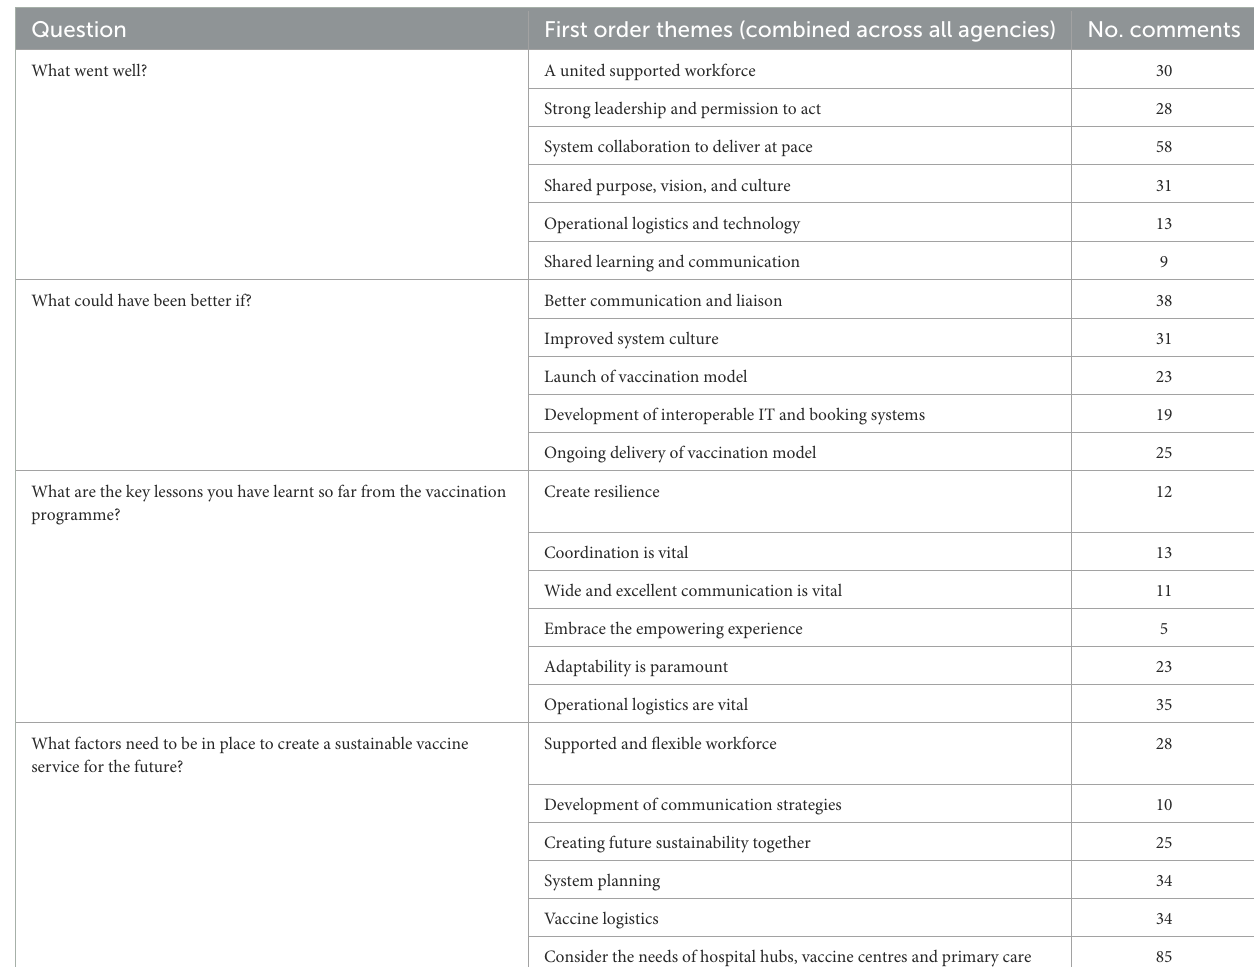
TABLE 1 Questions and first order themes for the rapid insight case example—NHS England—South west region rapid insight and learning from the COVID-19 mass vaccination programme.